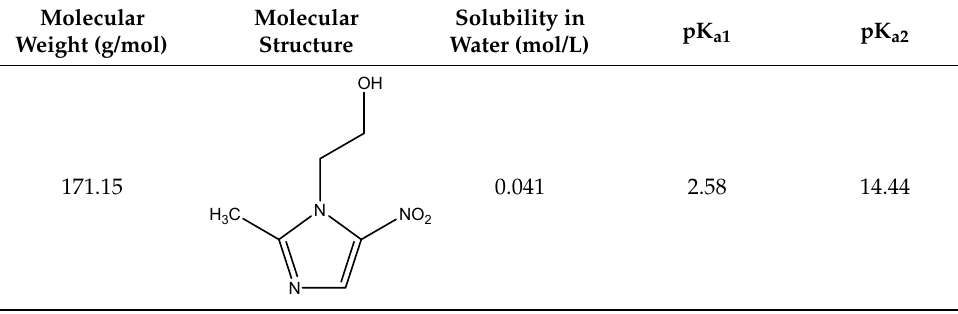
Table 1. Relevant characteristics of metronidazole (MNZ) [45,46].